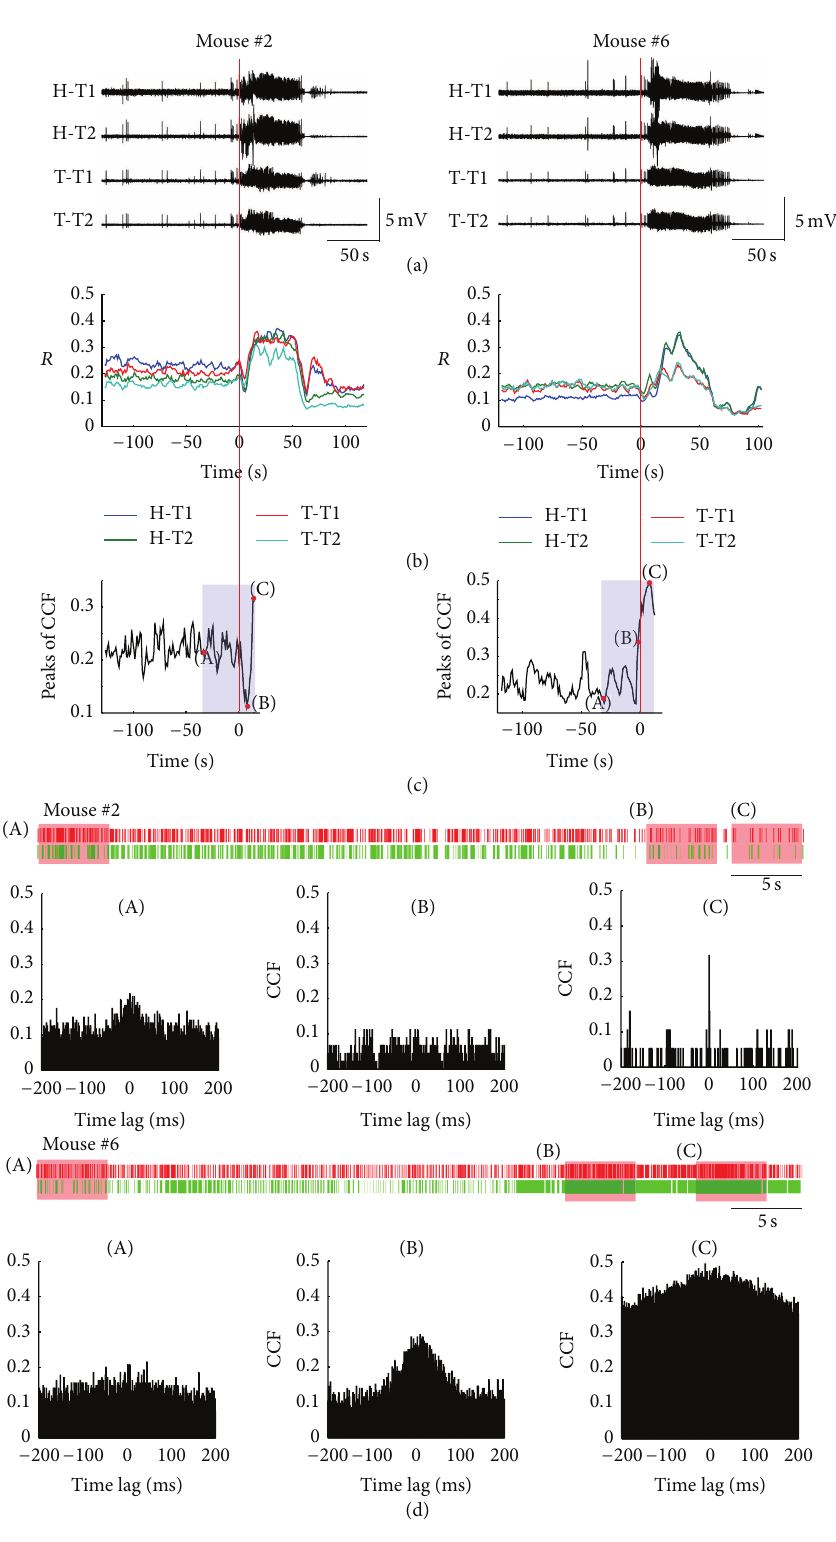
Figure 3: Peri-ictal changes of electrical brain activities as assessed by redundancy ( 𝑅 ) of LFP and cross-correlation function (CCF) of single- unit activities. (a) LFPs of two sample seizures from Mouse #2 and Mouse #6. Seizure onset is marked by red line. (b) Peri-ictal changes of 𝑅 of LFPs during the seizures shown in (a). (c) Dynamic changing of peak values of CCF of two neuronal spike trains sorted from tetrode H-T2 in Mouse #2 and tetrode T-T1 in Mouse #6. (d) Raster of the spikes from two neurons sorted from the two tetrodes above (shadows in (c)) and CCF in the periods of 5 s marked by (A), (B), and (C) in (c). H, hippocampus; T, thalamus; T1&T2, Tetrode 1 and Tetrode 2 in a